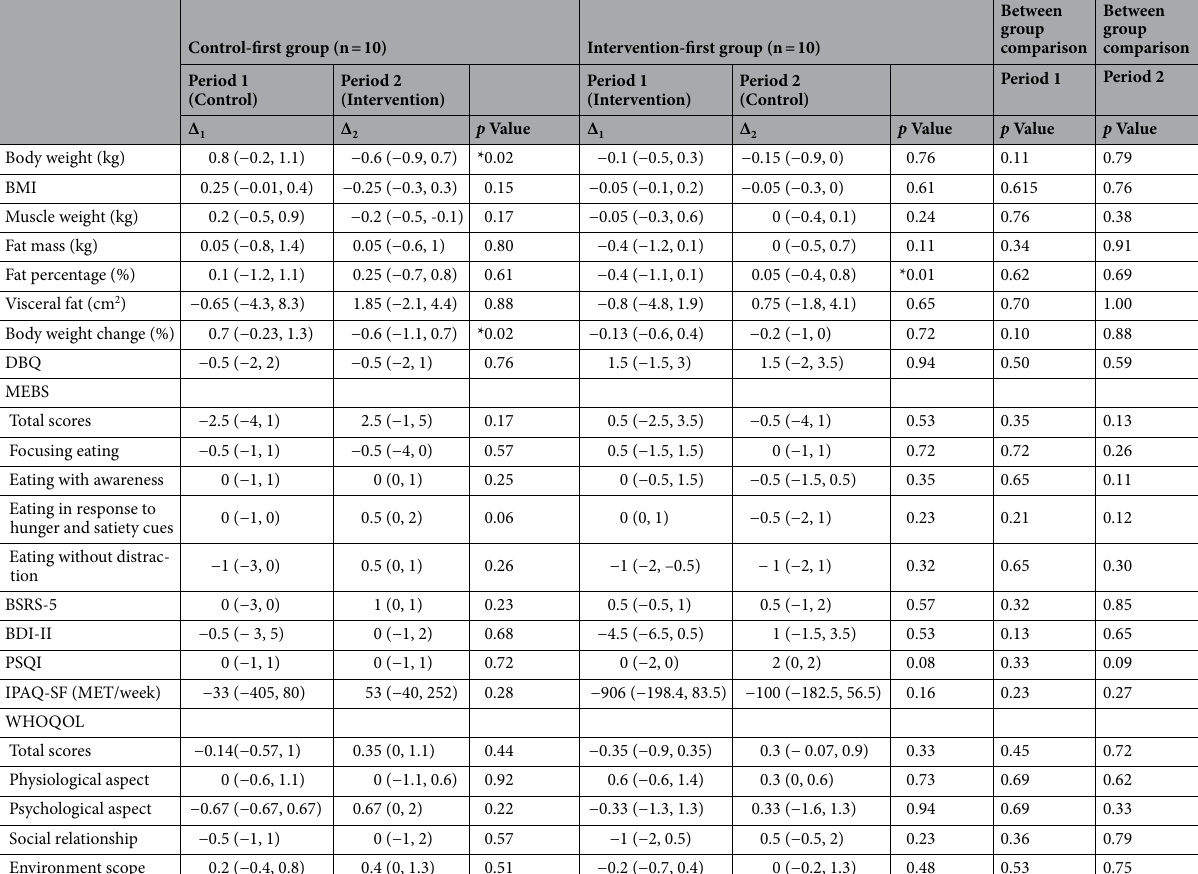
Table 2. Within-group and between group comparison of outcomes in different intervention period. DBQ Dietary Behavior Questionnaire; MEBS Mindful Eating Behavior Scale; BSRS-5 five-item Brief Symptoms Rating Scale; BDI-II Beck Depression Inventory II; PSQI Pittsburgh Sleep Quality Index; IPAQ-SF International Physical Activity Questionnaire Short Form; MET metabolic equivalent;. WHOQOL WHO quality of life. * p < 0.05, by Wilcoxon matched-pairs sign-rank test; Data were median (interquartile range). Δ 1 : median of differences between measures at baseline and day 30 (the end of period 1). Δ 2 : median of differences between measures at day 30 (the end of period 2) and day 60 (the end of period